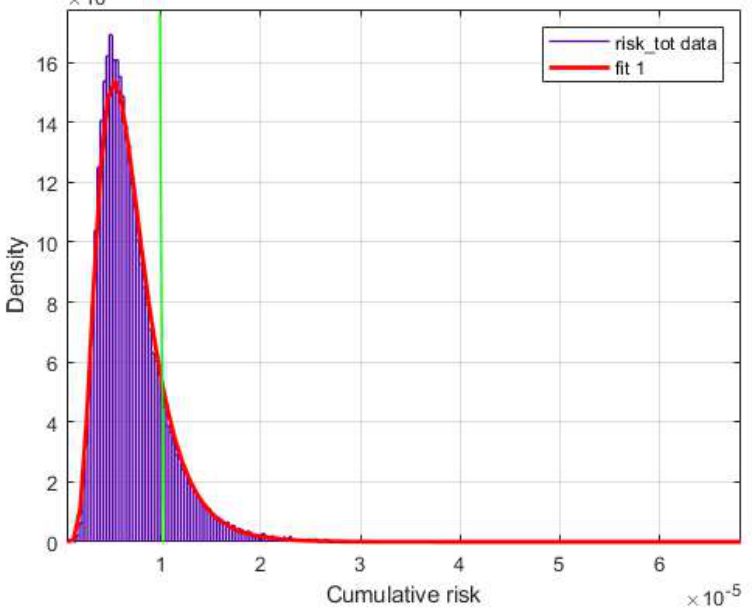
Figure 7. Probability distribution of the cumulative risk resulting from the Monte-Carlo simulations. The green line represents the benchmark value of 10 −5 .